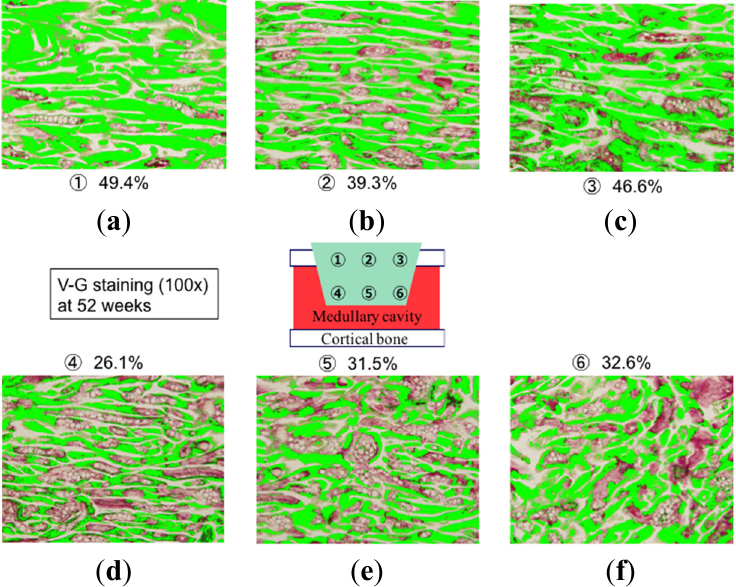
Figure 8. Histological findings undecalcified sections in Villanueva-Goldner staining at 52 weeks after UDPHAp transplantation. Bone is stained in green in the cortical ( a , b , and c ) and medullary ( d , e , and f )